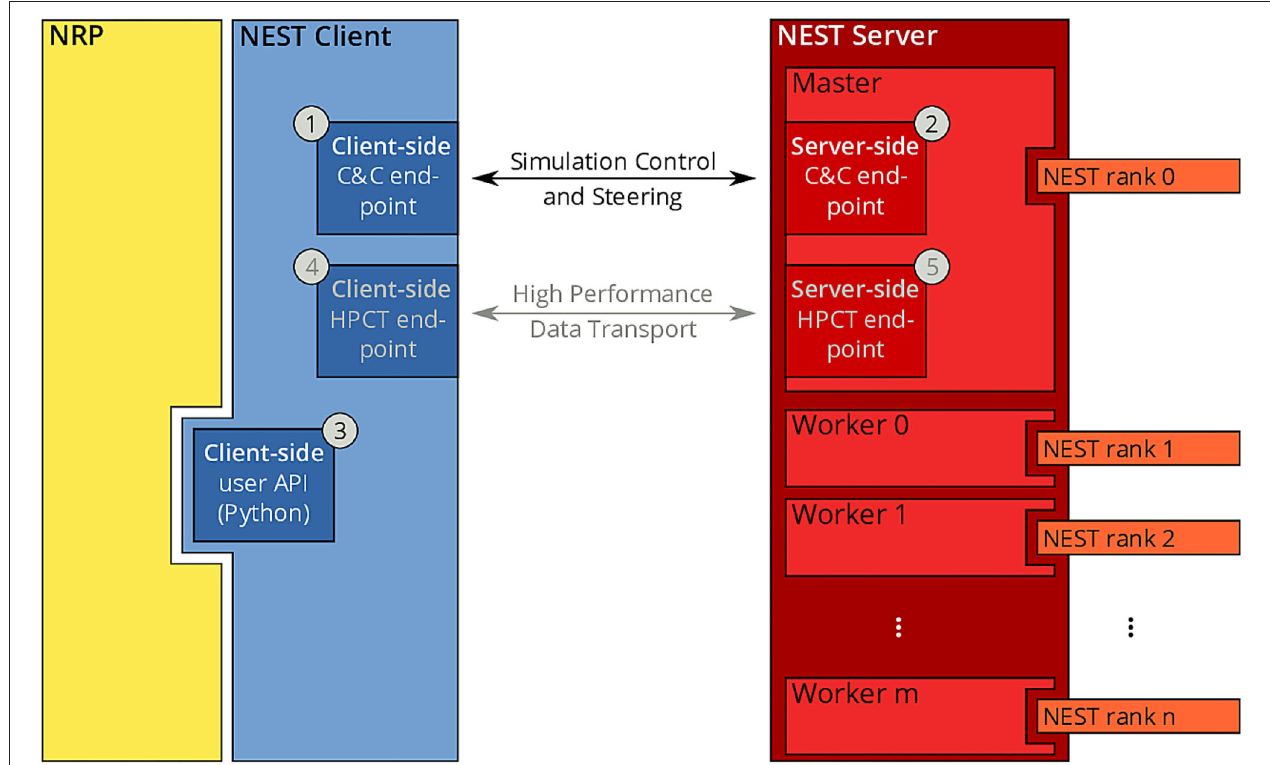
FIGURE 3 | NRP-NEST client-server architecture. The NRP (yellow) connects to the NEST Client via its client-side user API for Python 3 . The NEST Client (blue) provides a channel for talking to the NEST Server (between 1 and 2 ) for simulation control and steering. A high-performance transport layer for data (between 4 and 5 ) is possible, but not yet implemented. The NEST Server (red) encompasses all NEST MPI processes (rank 0 to n), but only rank 0 (Master) offers the RESTful API visible to the outside